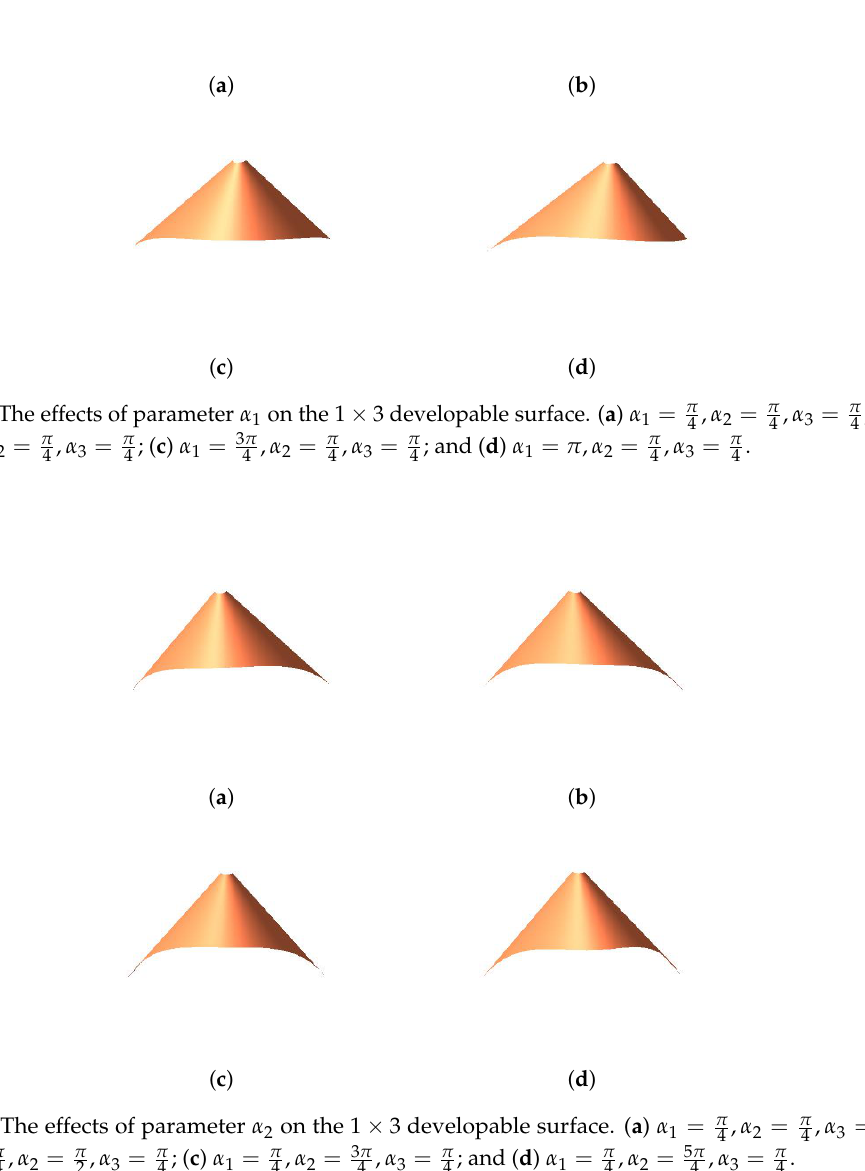
, α 2 = π , α 3 = π ; ( c ) α 1 = π 2 4 4